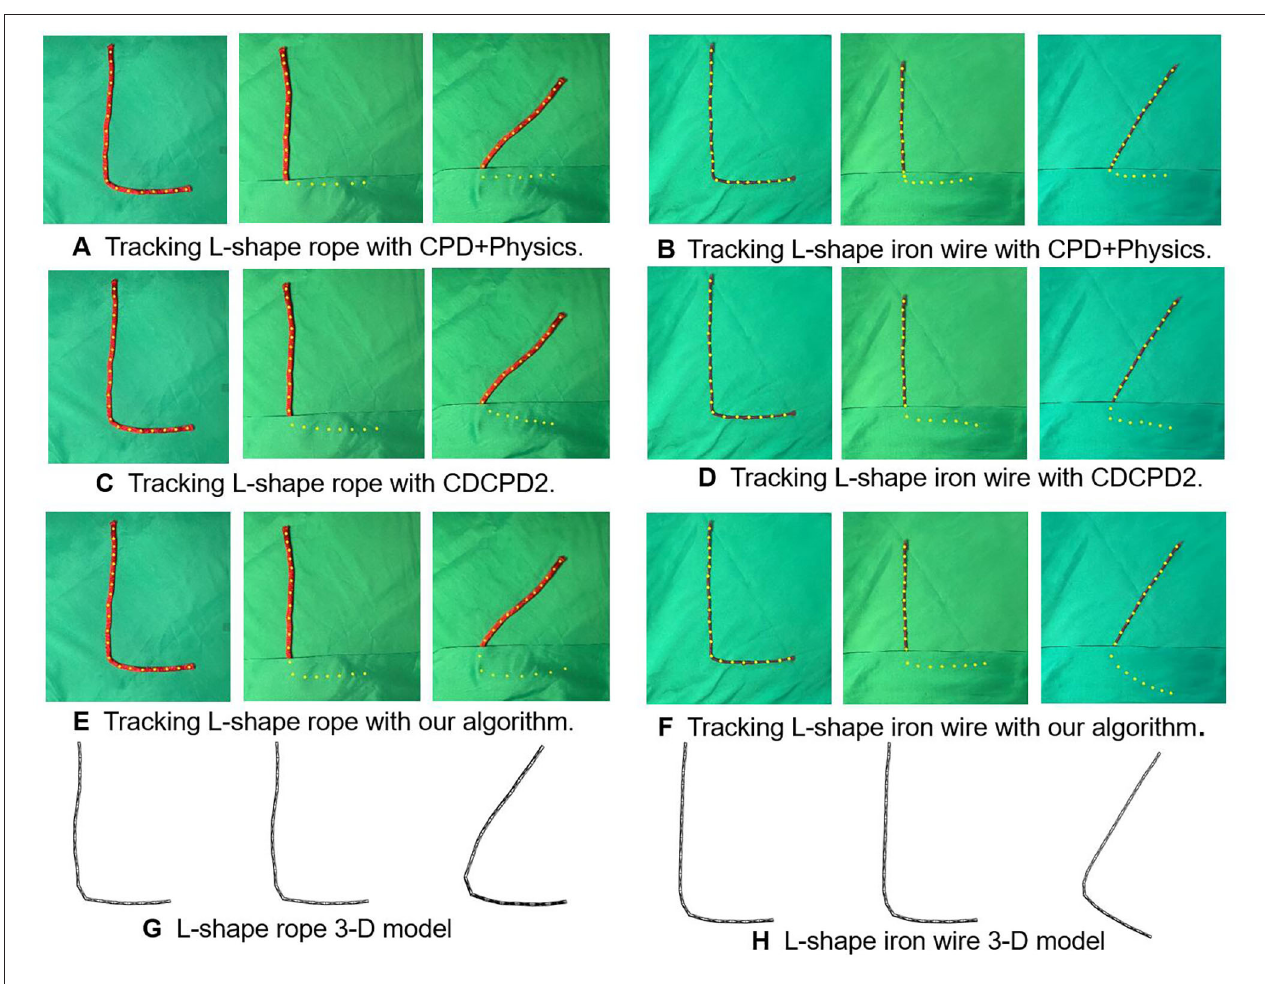
FIGURE 8 | L-shaped registration results of rope and iron wire with occlusions. (A) Tracking L-shape rope with CPD+Physics. (B) Tracking L-shape iron wire with CPD+Physics. (C) Tracking L-shape rope with CDCPD2. (D) Tracking L-shape iron wire with CDCPD2. (E) Tracking L-shape rope with our algorithm. (F) Tracking L-shape iron wire with our algorithm. (G) L-shape rope 3-D model. (H) L-shape iron wire 3-D